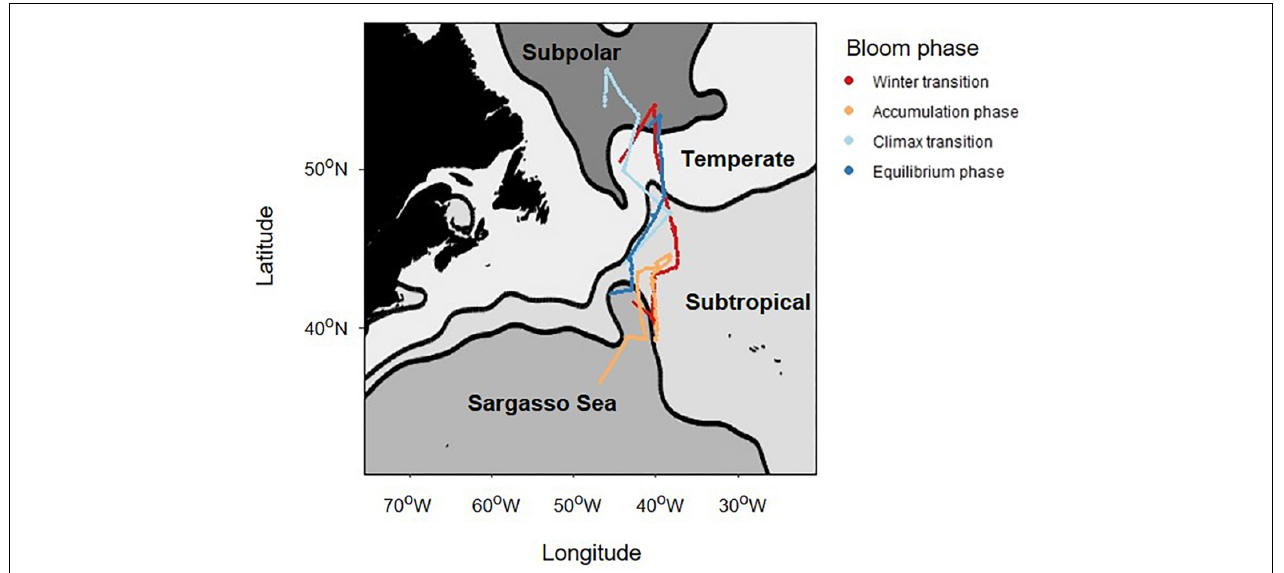
FIGURE 1 | A map of the NAAMES study region showing the North Atlantic sub-regions identified by Della Penna and Gaube (2019) using dynamic topography. The colored lines indicate the cruise track of each field campaign. For the purposes of this report, the northern regions were combined into the “subarctic region,” and the southern regions were combined into the “subtropical